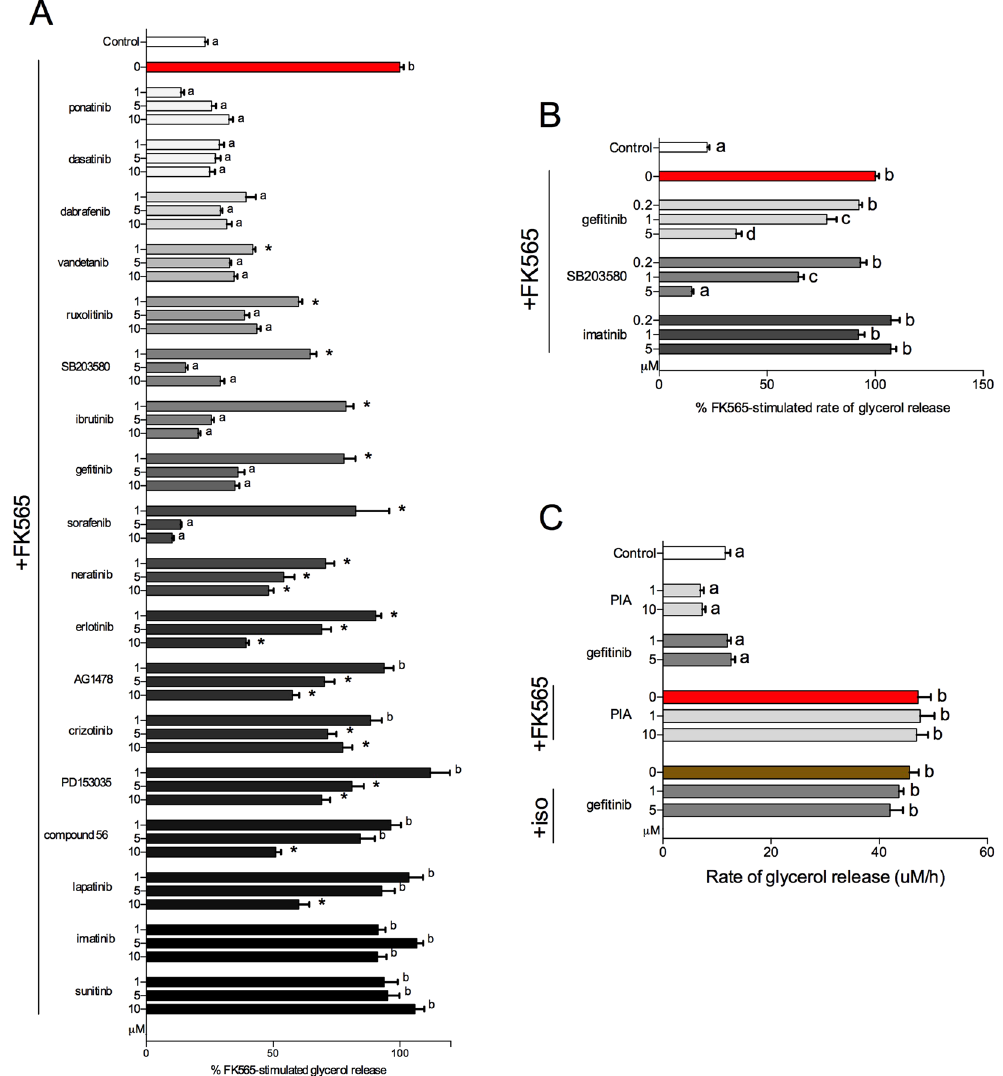
Figure 1. Selected TKIs inhibit bacterial cell wall-mediated lipolysis in adipocytes. Relative levels of glycerol released from 3T3-L1 adipocytes after stimulation with the Nod1 ligand FK565 (10 μ g/mL) for 48 h and pre- incubated for 1 h with 1, 5 or 10 μ M of various TKIs ( A ) n = 6–69. Rate of glycerol release over 48 h in 3T3-L1 adipocytes pre-incubated for 1 h with 0.2, 1 or 5 μ M gefitinib, SB203580, and imatinib ( B ) n = 8–49. Rate of glycerol release over 48 h in 3T3-L1 adipocytes pre-incubated for 1 h with PIA (1 or 10 μ M) and stimulated with FK565 (10 μ g/mL), or pre-incubated with gefitinib (1 or 5 μ M) and stimulated with isoproterenol (2 μ M) respectively ( C ) n = 6–10. Values are mean ± SEM. Conditions with different letters (a, b, c) denote a statistical difference compared to all other conditions without the same letter (P < 0.05). * Denotes partial inhibition that is statistically lower than FK565-stimulated glycerol release, but significantly higher than basal glycerol release for a given TKI (p <